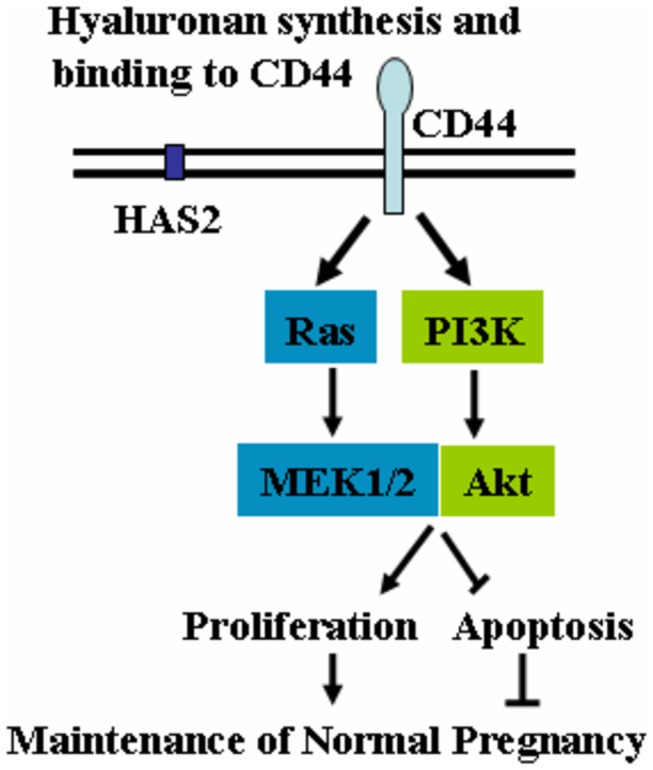
A proposed model for the role of HA in growth of DSCs in human early pregnancy.DSCs from normal pregnancy express higher HAS2, which synthesize higher molecular size of HA. HMW-HA activates PI3K/Akt and MAPK/ERK1/2 signalings via binding to CD44 in DSC membrane and then promotes cell proliferation while inhibits cell apoptosis, which is beneficial to normal pregnancy maintenance.